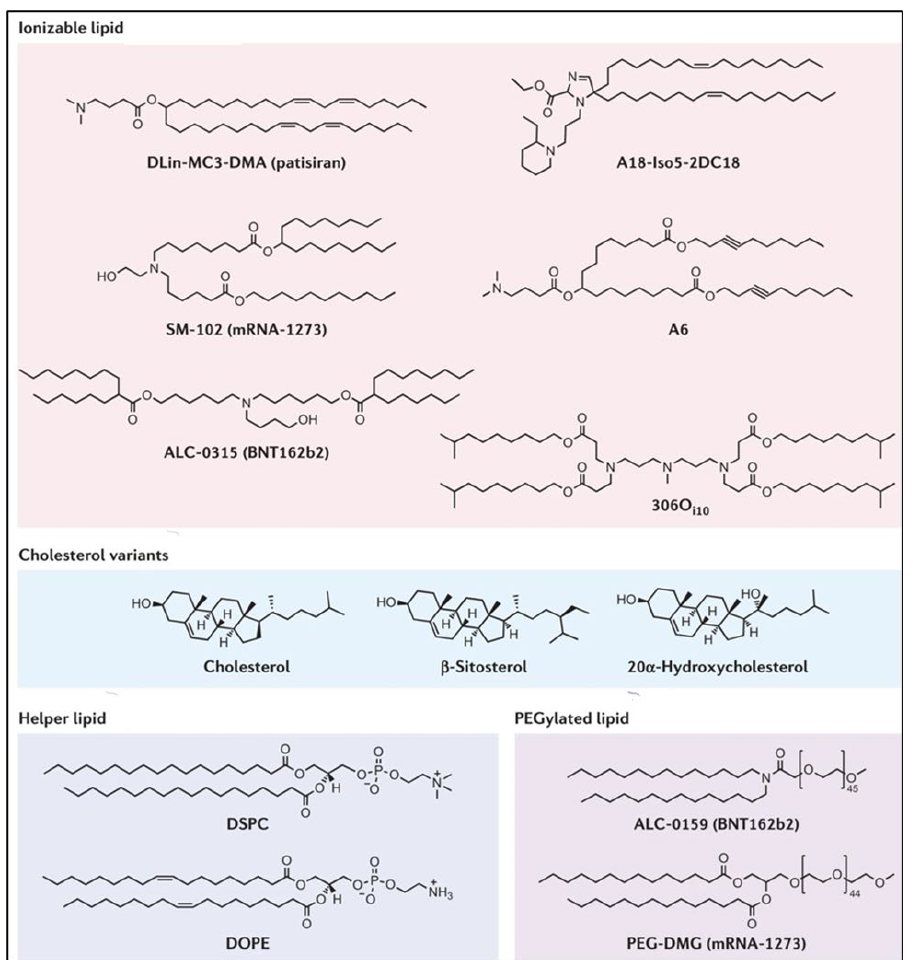
Figure 4. Components of lipid nanoparticles including ionizable lipids, cholesterol, helper lipids, and PEGylated lipids [35].